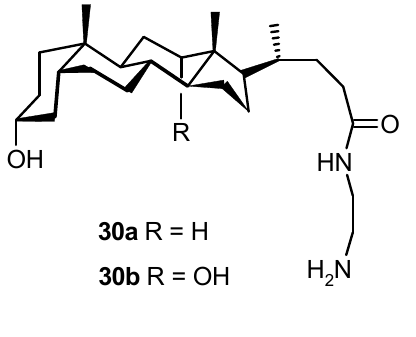
Figure 19. Structures of bile acid N -(2-aminoethyl)amides